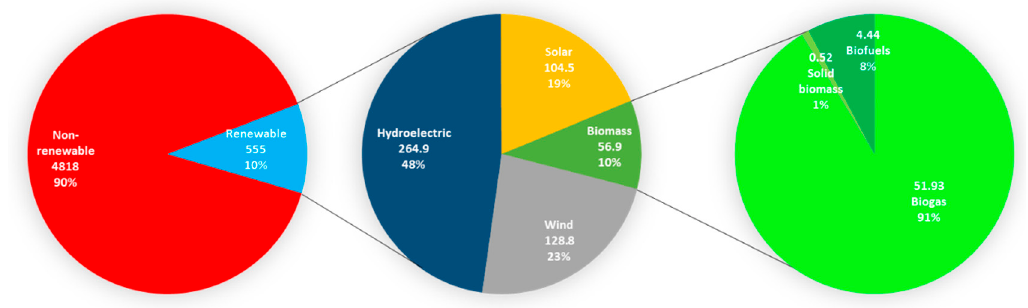
Figure 5. Provenience of the electrical energy produced in Liguria in 2018 (in GWh).